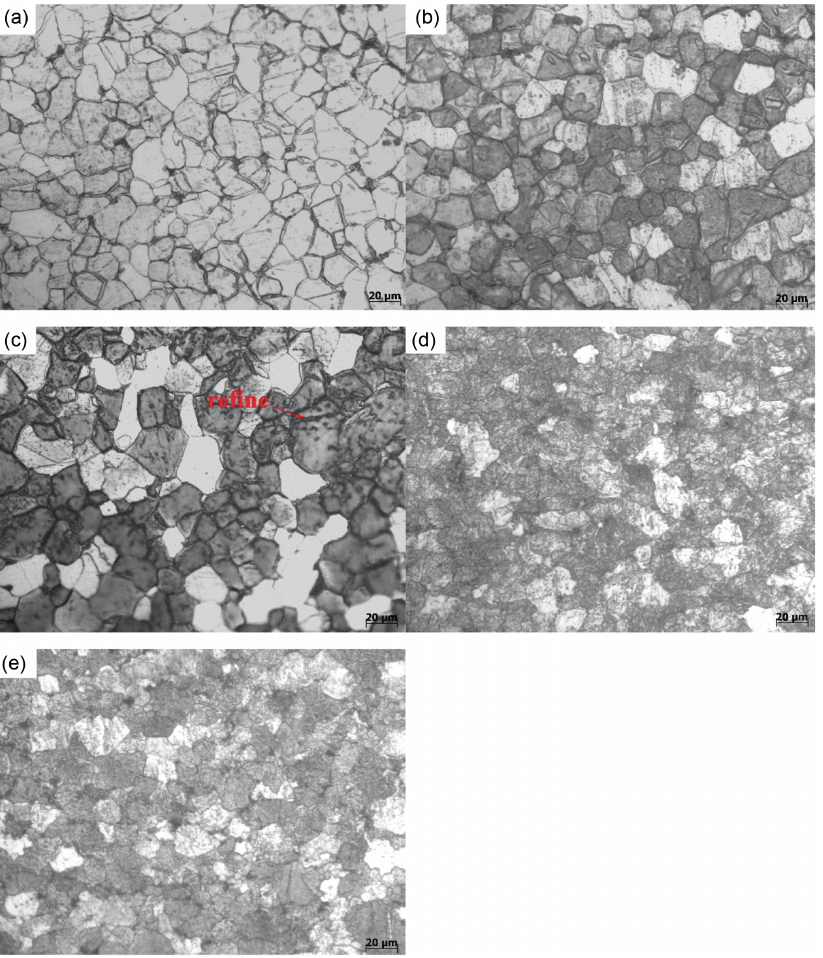
Figure 10: Optical microstructure of ultra-high strength steel BR1500HS at strain rate 0.01s – 1 under different deformation temperatures (tensile axis is vertical): (a) 773K, (b) 873K, (c) 1,023K, (d) 1,123K, (e)